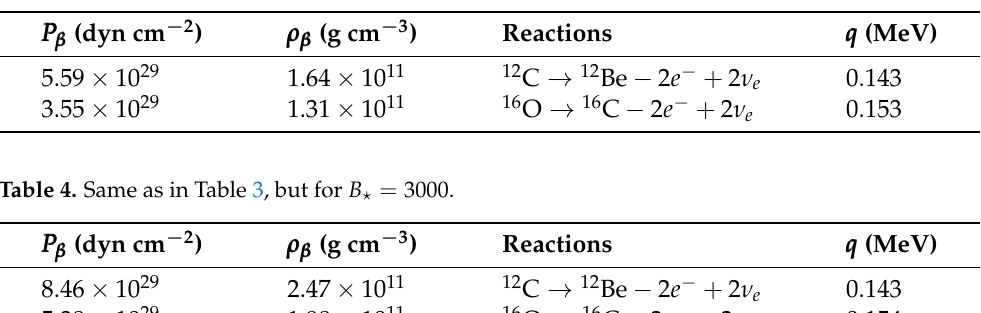
Table 3. Maximum possible heat released q per nucleon (in MeV) from electron captures by carbon and oxygen in the outer crust of a magnetar with B (cid:63) = 2000. The pressure P β (in dyn cm − 2 ) and density ρ β (in g cm − 3 ) at which electron capture occurs are given considering ground-state-to-ground- state transitions.